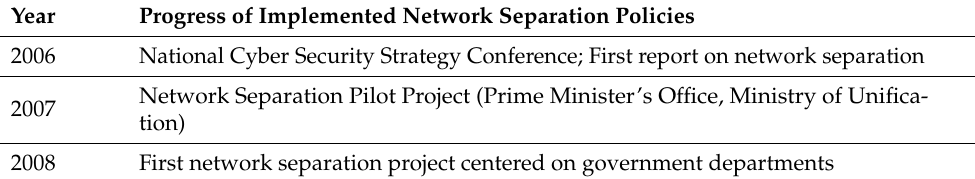
Table 1. Progress of network separation policies implementation by the Republic of Korea govern-